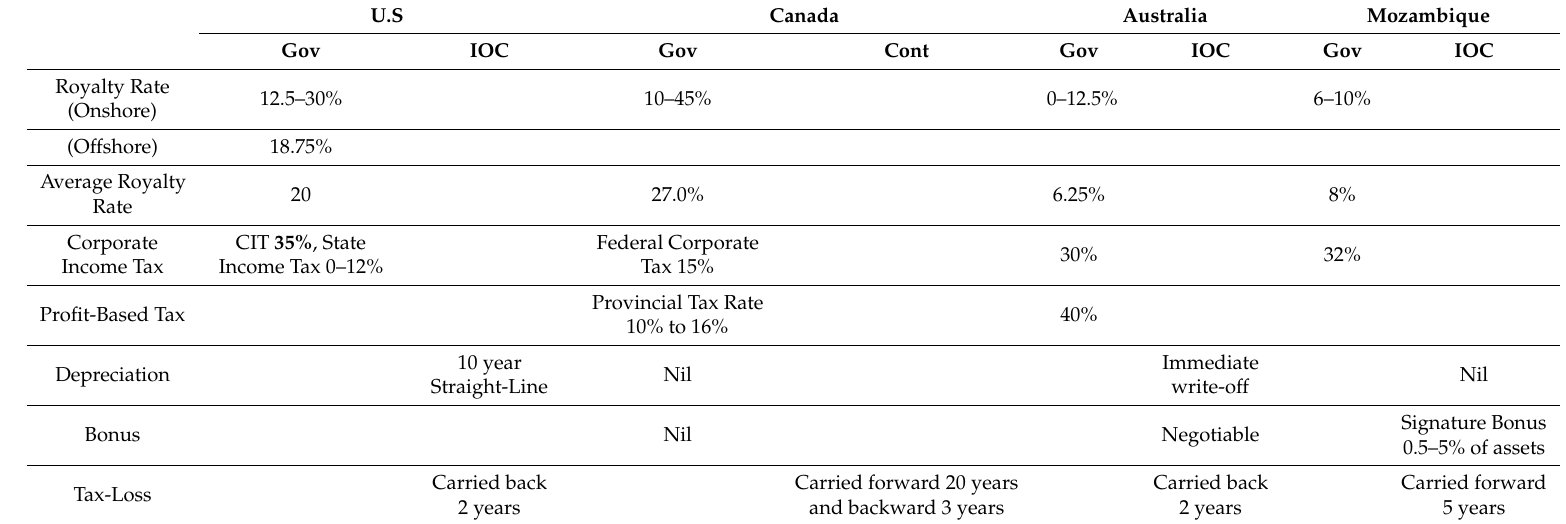
Table 5. Petroleum Fiscal Regimes of Concessionary